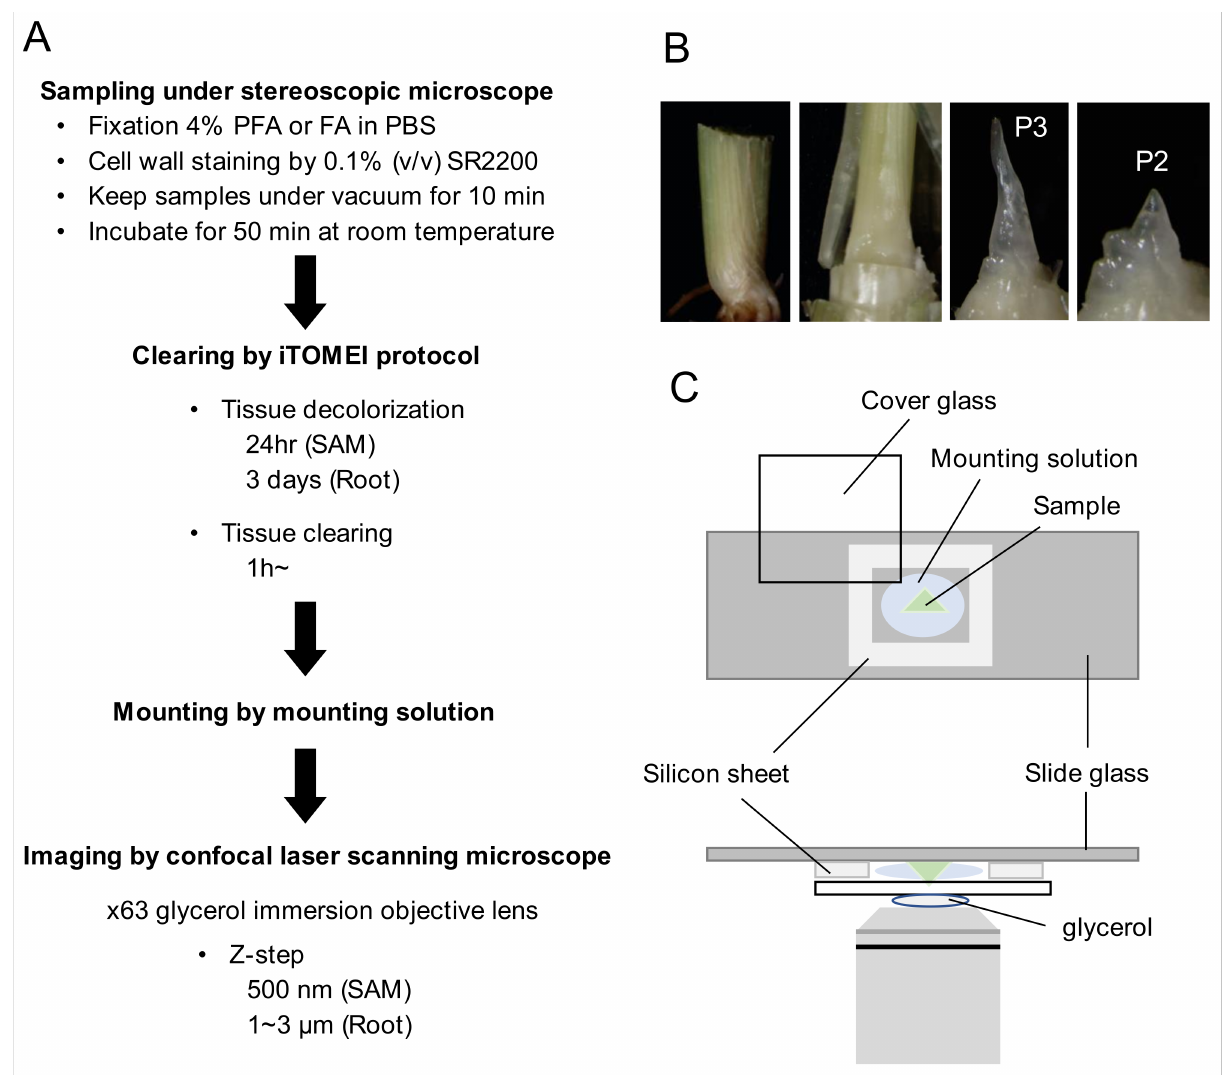
Figure 1. ( A ) Overview of the imaging protocol. ( B ) Sampling of a shoot apex. Far left: basal region of a seedling; middle left, after removing the outer three leaves; middle right, shoot apex with a P3 primordium; far right: shoot apex with a P2 primordium. ( C ) Mounting and preparation for imaging by confocal laser scanning microscopy. Upper: Samples were mounted on a silicon sheet with a square piece removed to maintain the 3D structure of tissues. Lower: a 63 × glycerol-immersion objective lens was used. Bars; 100 µ